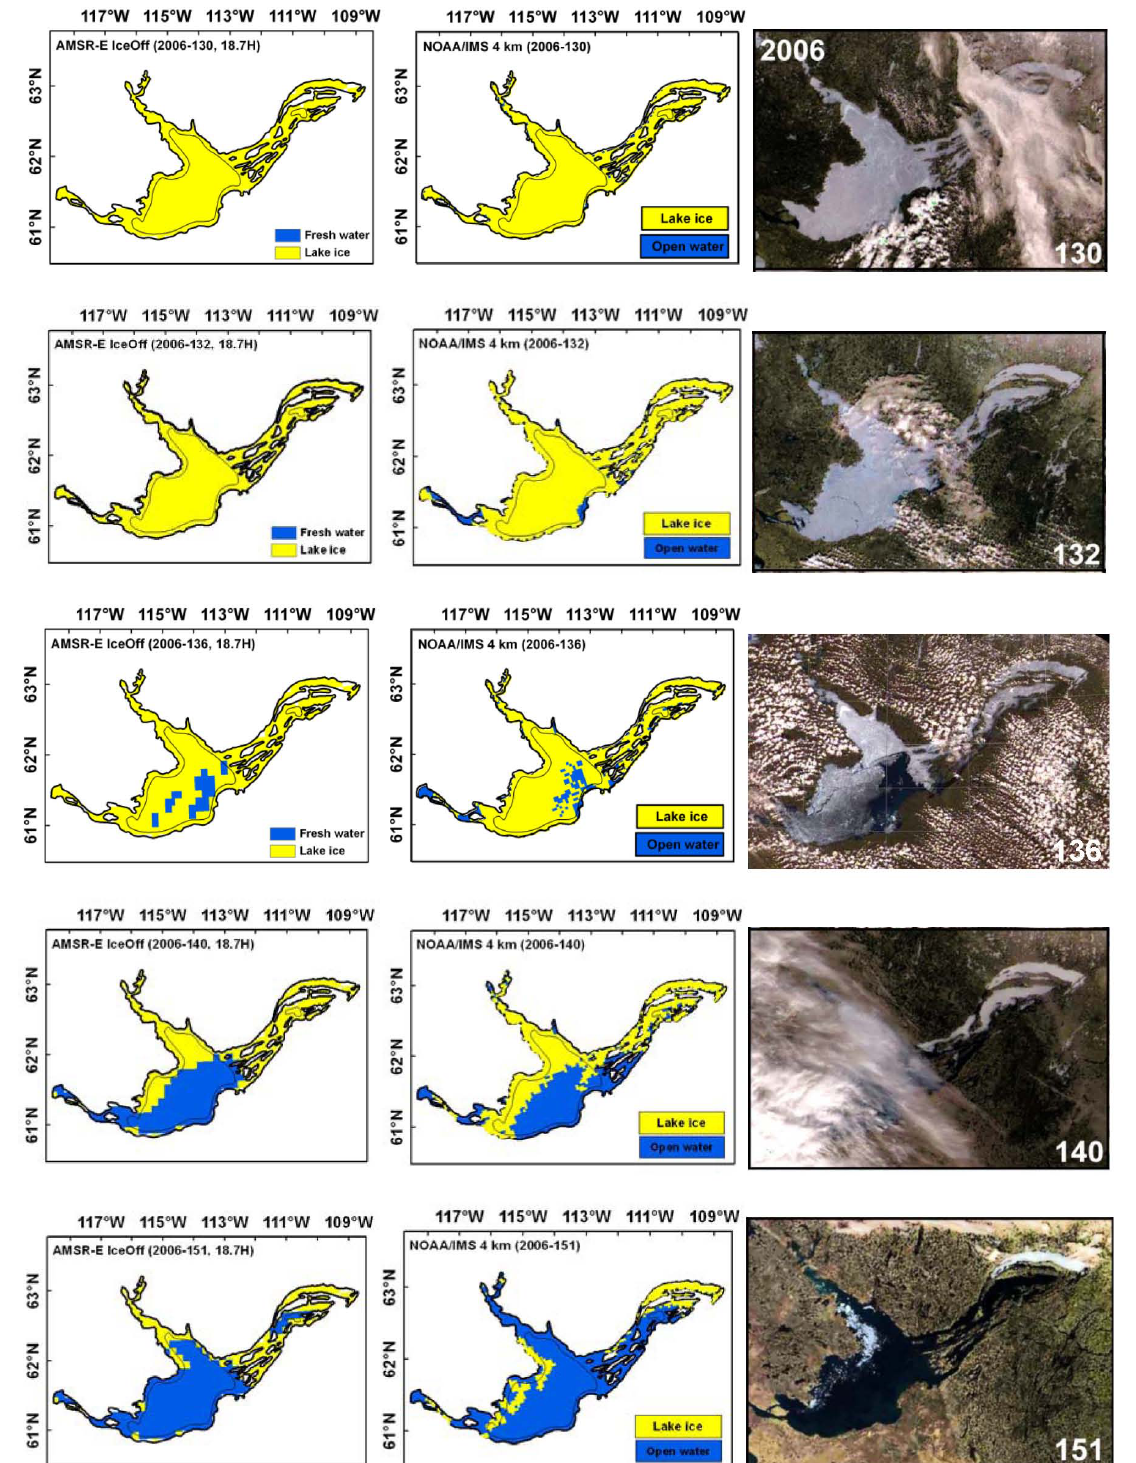
Fig. 9. Comparison of AMSR-E (left) and NOAA/IMS (center) ice-off, and MODIS/Terra image (right) acquired on the same day during the break-up period of ice season 2005–2006 on